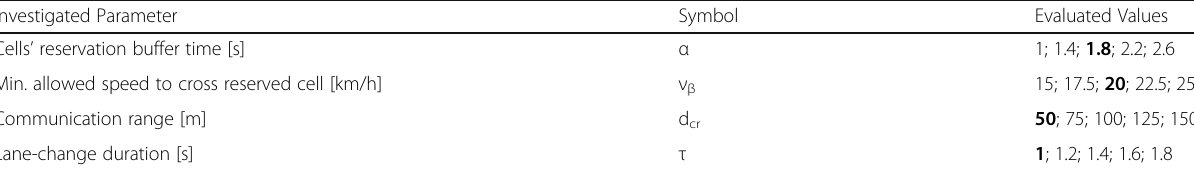
Table 1 Analyzed control-based parameters Investigated Parameter